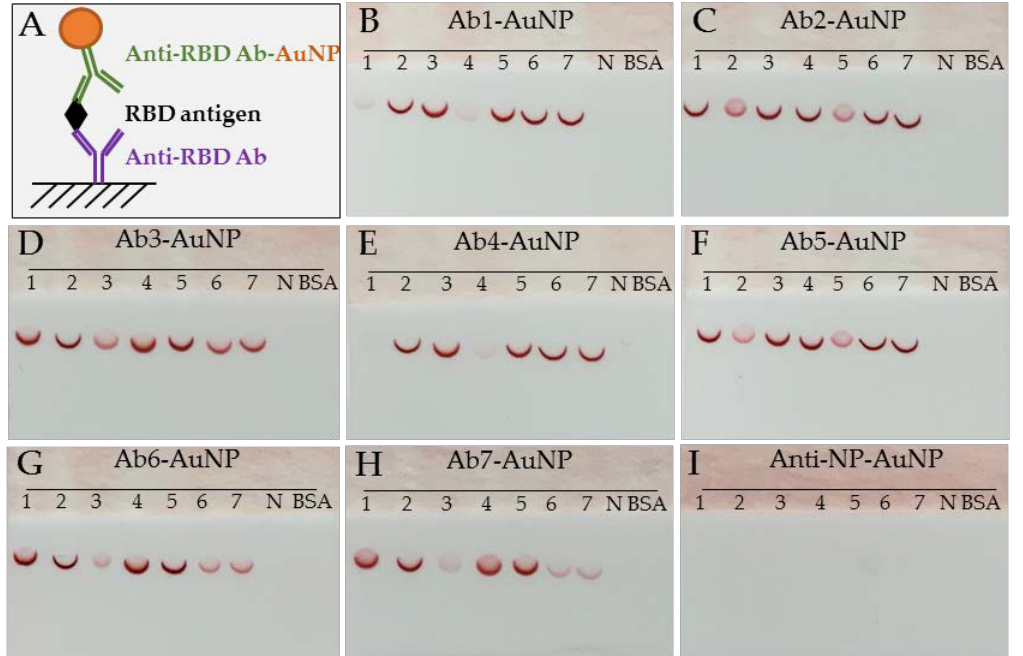
Figure 3. Antibody pairing capability and epitope binning. ( A ) Sandwich immunoassay principle. ( B – I ) Photographs of a representative set of lateral flow dipstick assays. Each dipstick has 9 spots: 7 spots for the antibodies of interest and 2 spots for the negative controls (i.e., anti-nucleocapsid antibody and BSA). (Note 1) A dark red colored crescent line or circular spot indicates strong binding activity, a light red colored crescent line or circular spot indicates weak binding activity, and an empty spot indicates no binding activity. (Note 2) All Ab-AuNP conjugates used were coated with 50 μg of antibody per mL of 20 OD AuNP solution, except Ab7-AuNP, which was coated with 20 μg of antibody per mL 20 OD AuNP. For anti-nucleocapsid antibodies, clone 1,035,138 (N) was used as a capture negative control, and clone 1,035,101 (anti-NP) was used as a detector negative control. Table 1. Epitope bin and pairing summary.